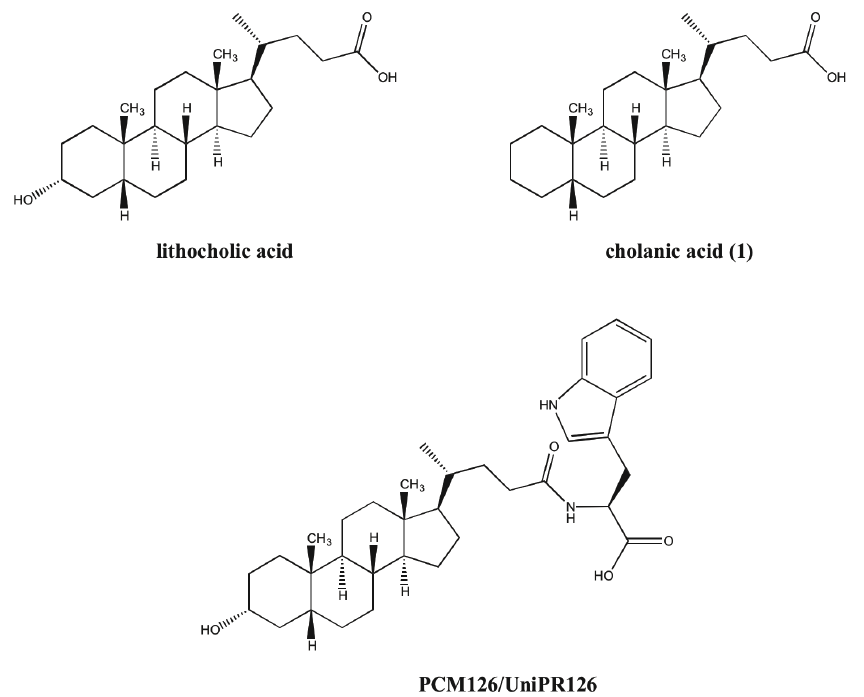
Figure 1. Chemical structure of lithocholic acid, cholanic acid ( 1 ) and PCM126